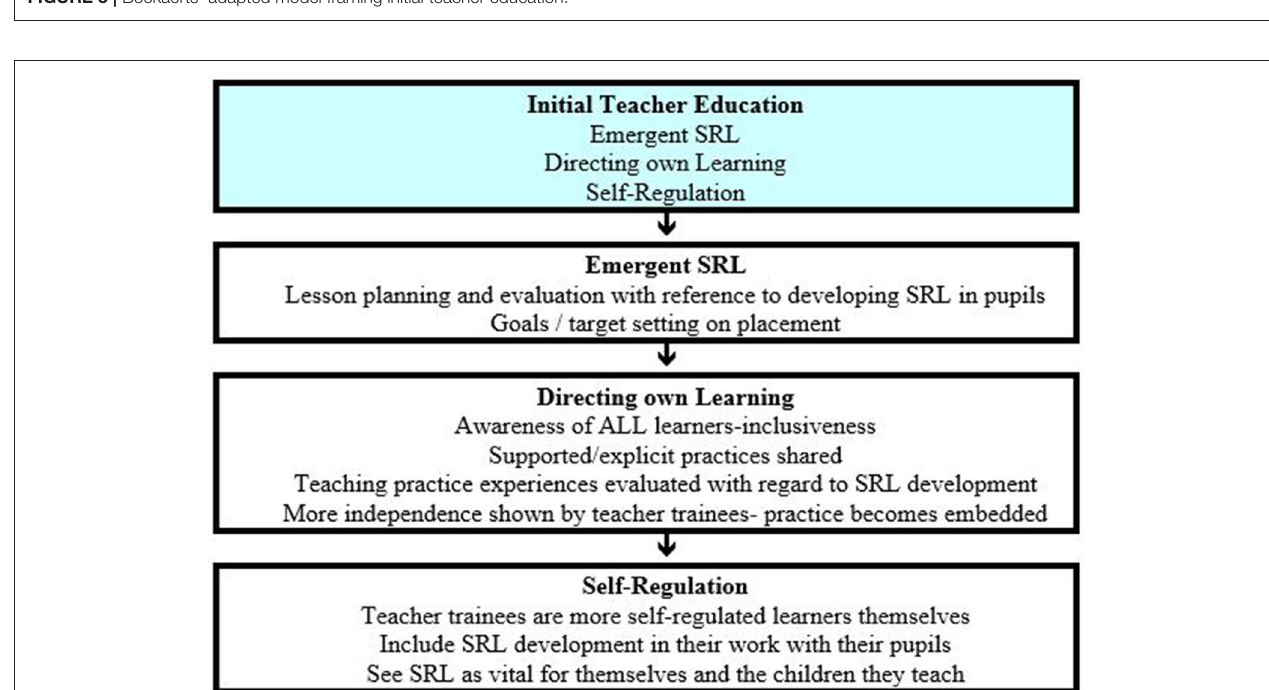
FIGURE 3 | Boekaerts’ adapted model framing initial teacher education.